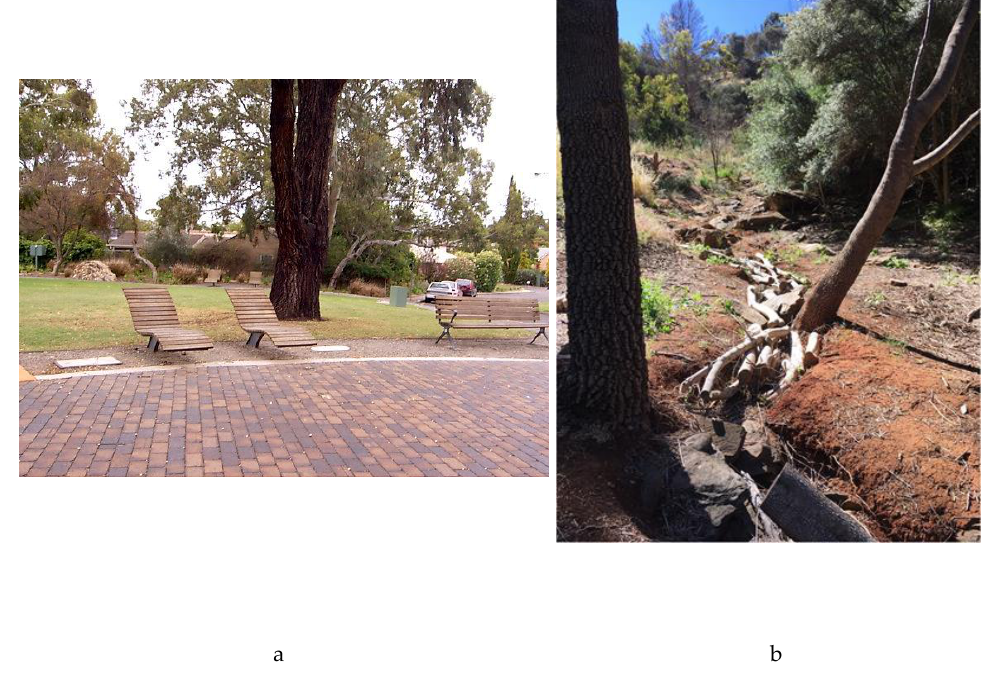
Figure 2. Examples of public green space images uploaded with audits. Figure ( a ) shows a more formal park space while ( b ) highlights some of the more natural “bushland” spaces.